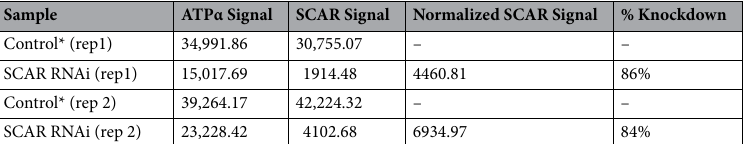
Table 2. Knockdown efficiency of the SCAR RNAi line used in this study. *Control refers to vermillion (unrelated gene) knockdown.